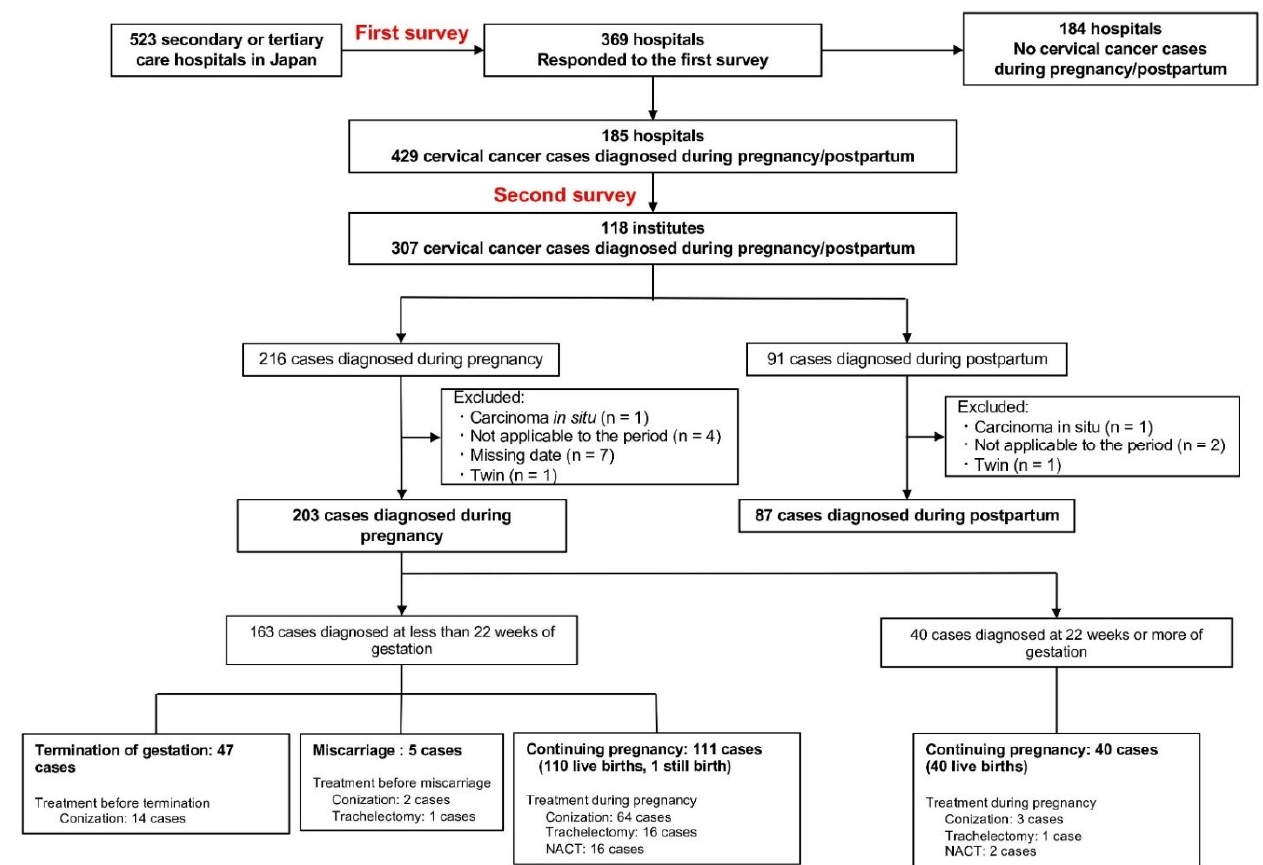
Figure 1. Patient inclusion flow chart. NACT, neoadjuvant chemotherapy.